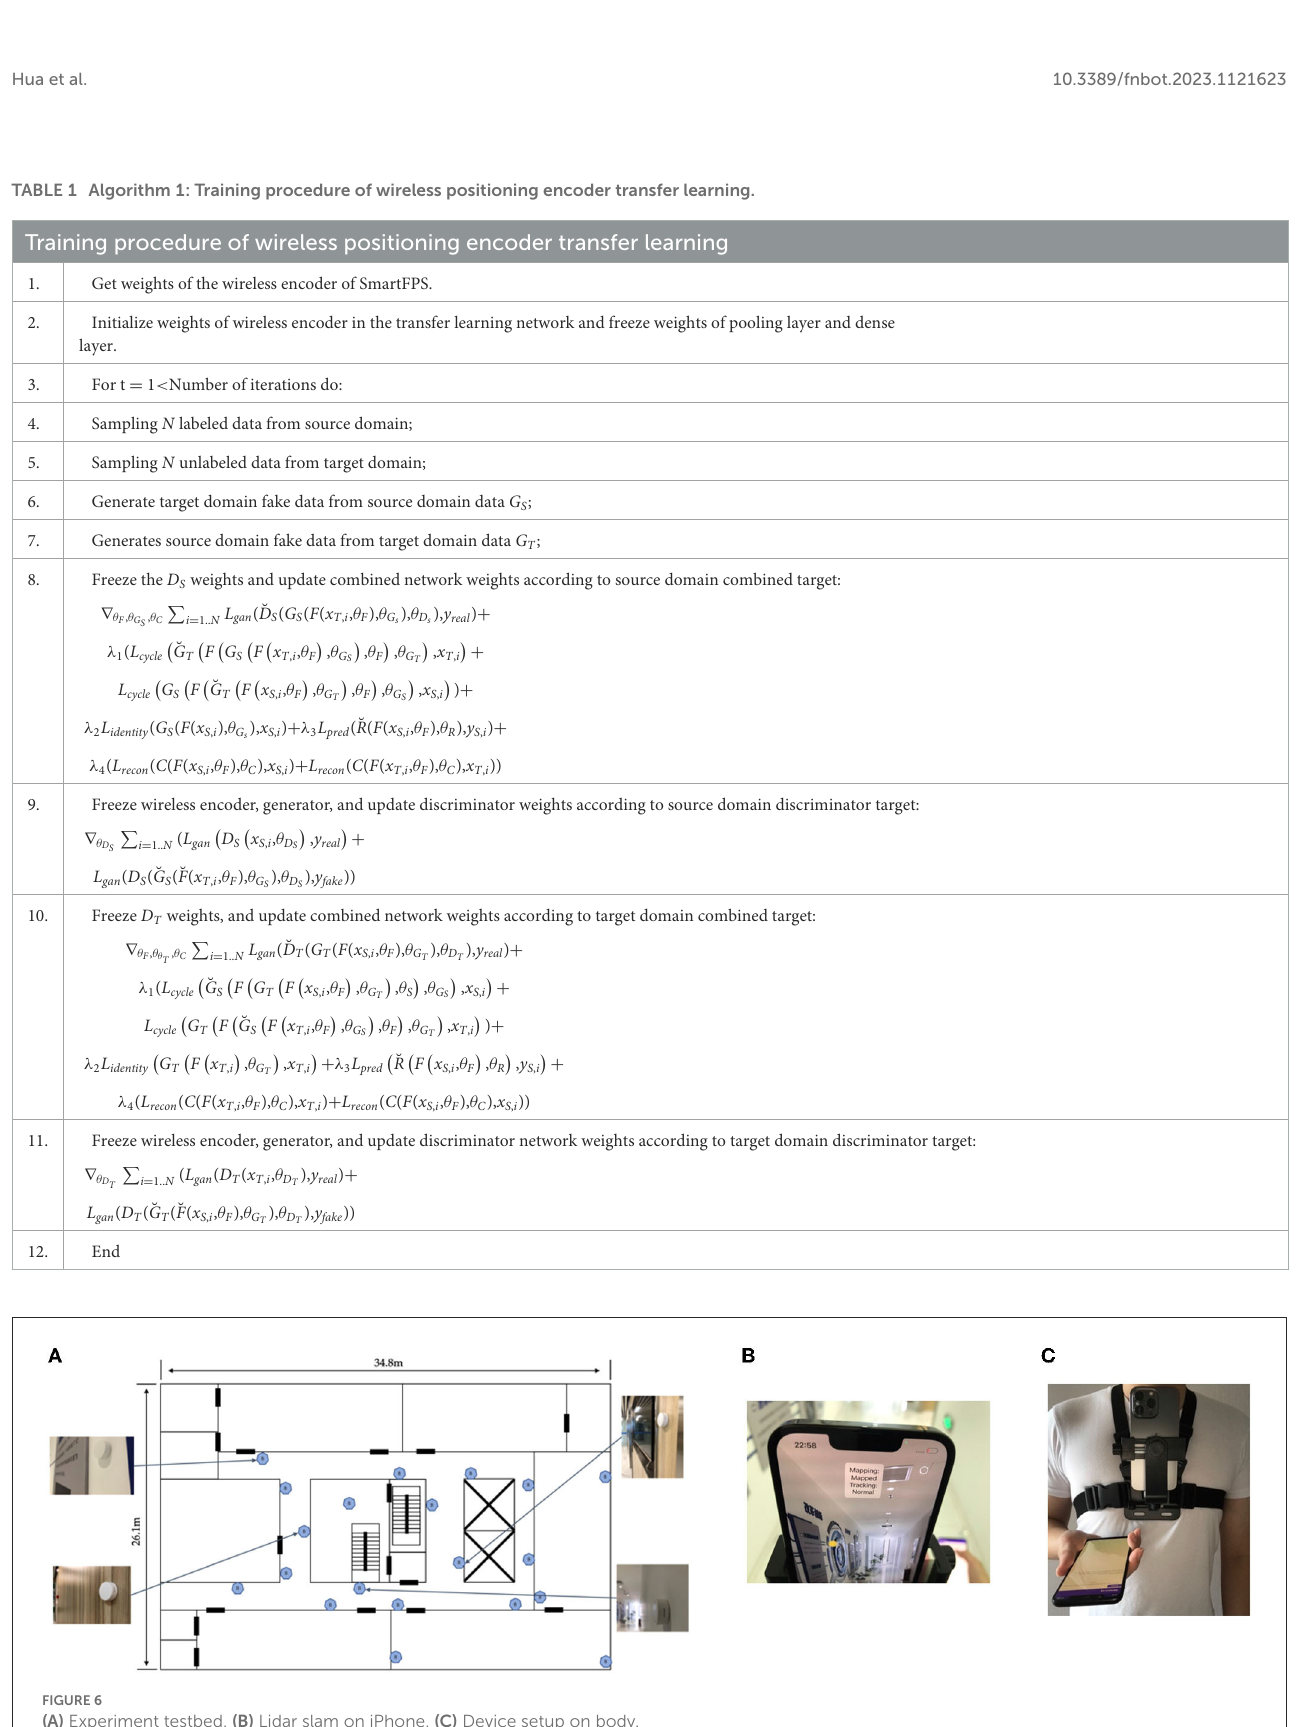
whole process, and walking according to the reference line every 15 min. By comparing the walking trajectories of the reference routes in different periods, we found that the cumulative drift error of the iPhone’s Lidar SLAM system does not exceed 20cm in 1